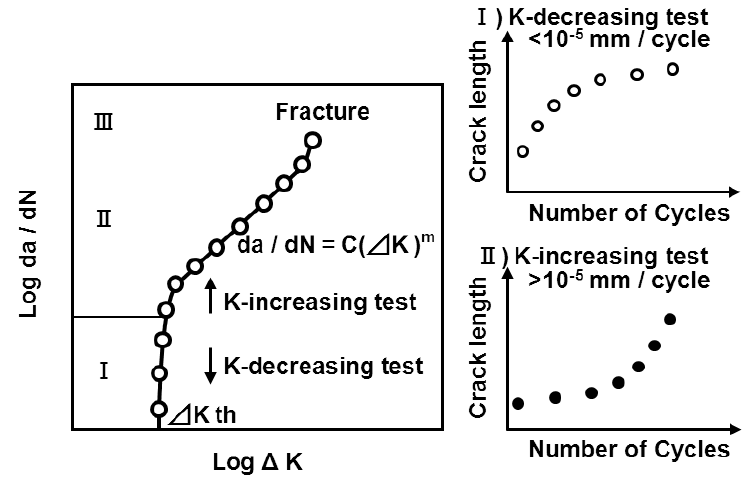
Figure 4. Testing method for fatigue crack growth